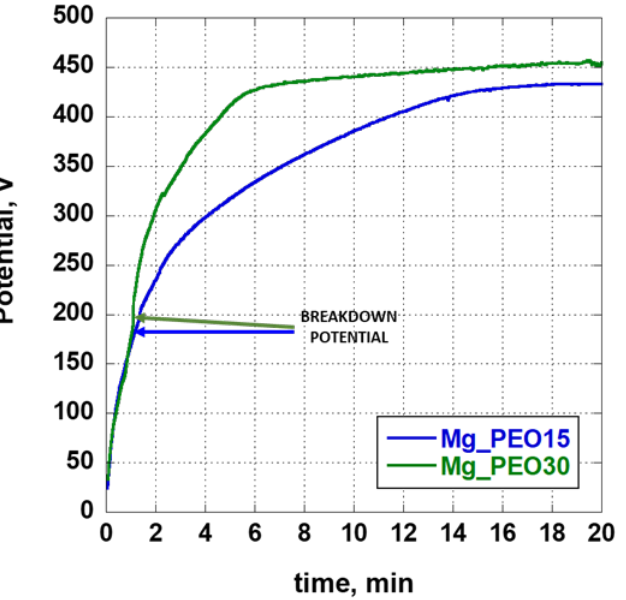
Figure 2. Voltage-time curves of the samples treated applying a current density of 15 mA/cm 2 (blue curve) or 30 mA/cm 2 (green curve).